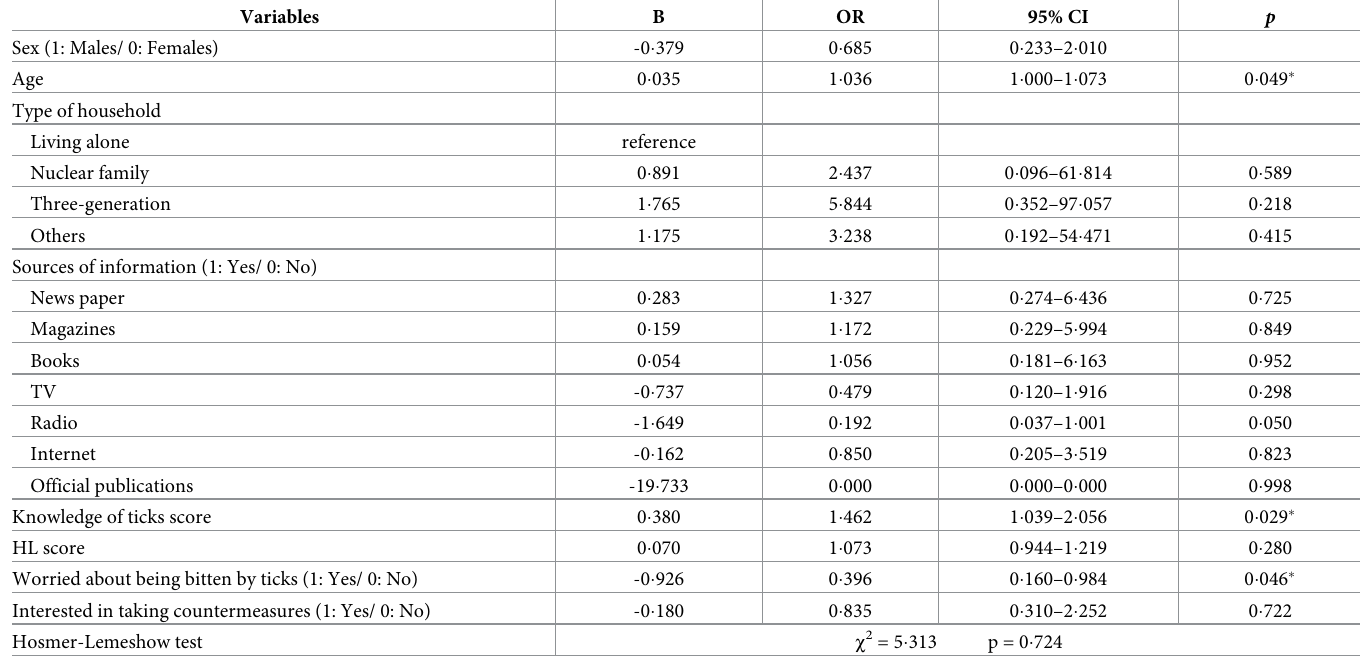
Table 5. Multiple logistic regression analysis with the practice of countermeasures against ticks as the dependent